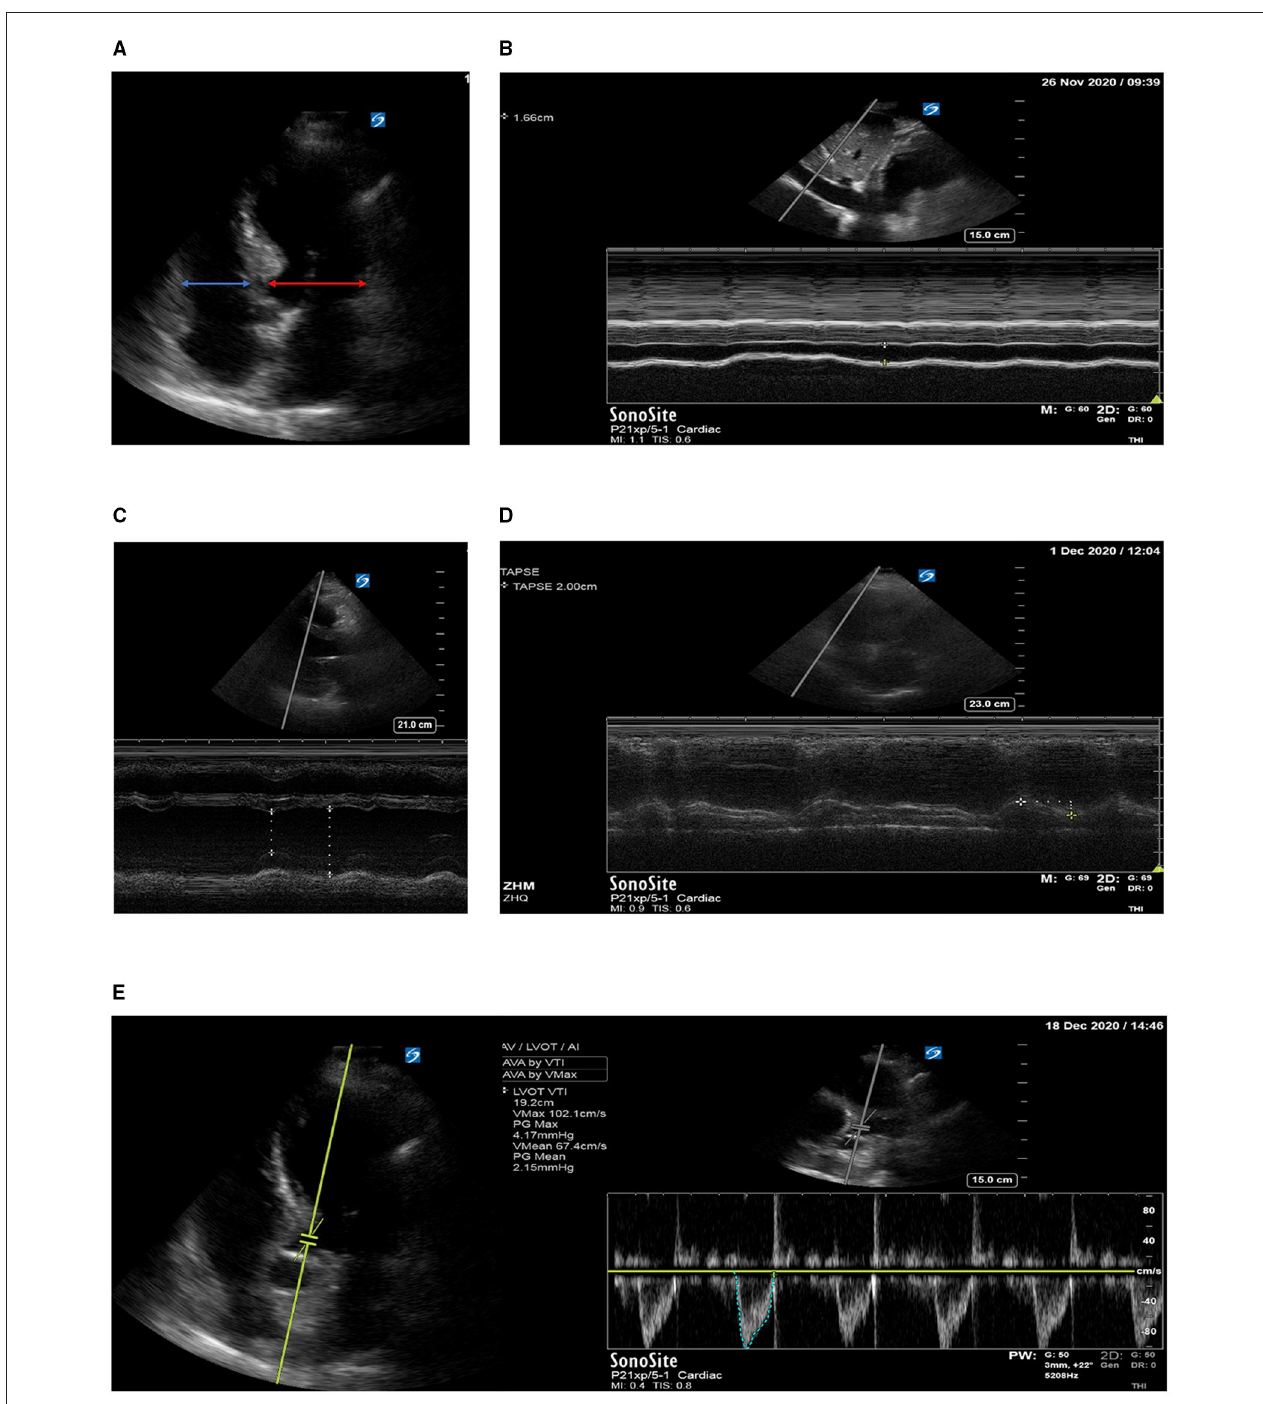
FIGURE 1 | (A) Right to left ventricular diastolic dimensions ratio (RV D /LV D ratio); (B) diameter of the inferior vena cava; (C) left ventricular eject fraction EF; (D) tricuspid annular plane systolic excursion TPASE; (E) left ventricular outflow tract velocity time integral VTI.